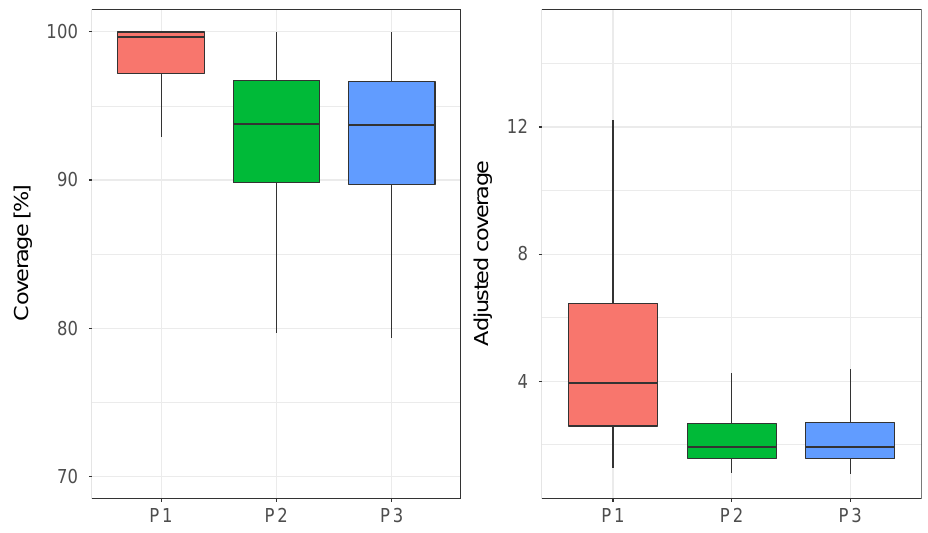
Figure 4. Coverage and adjusted coverage for the 95% HDIs obtained in Phases 1, 2 and 3 of model